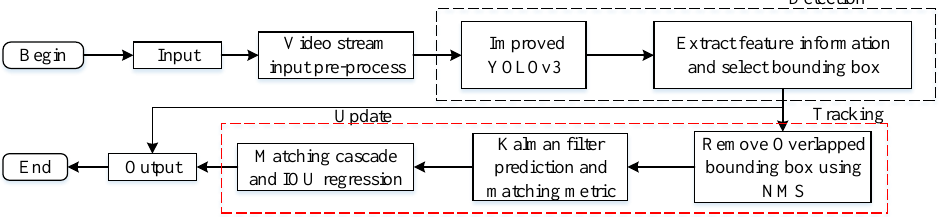
Figure 5. Improved structure for detection-and-tracking. Algorithm 1 Detection and Tracking